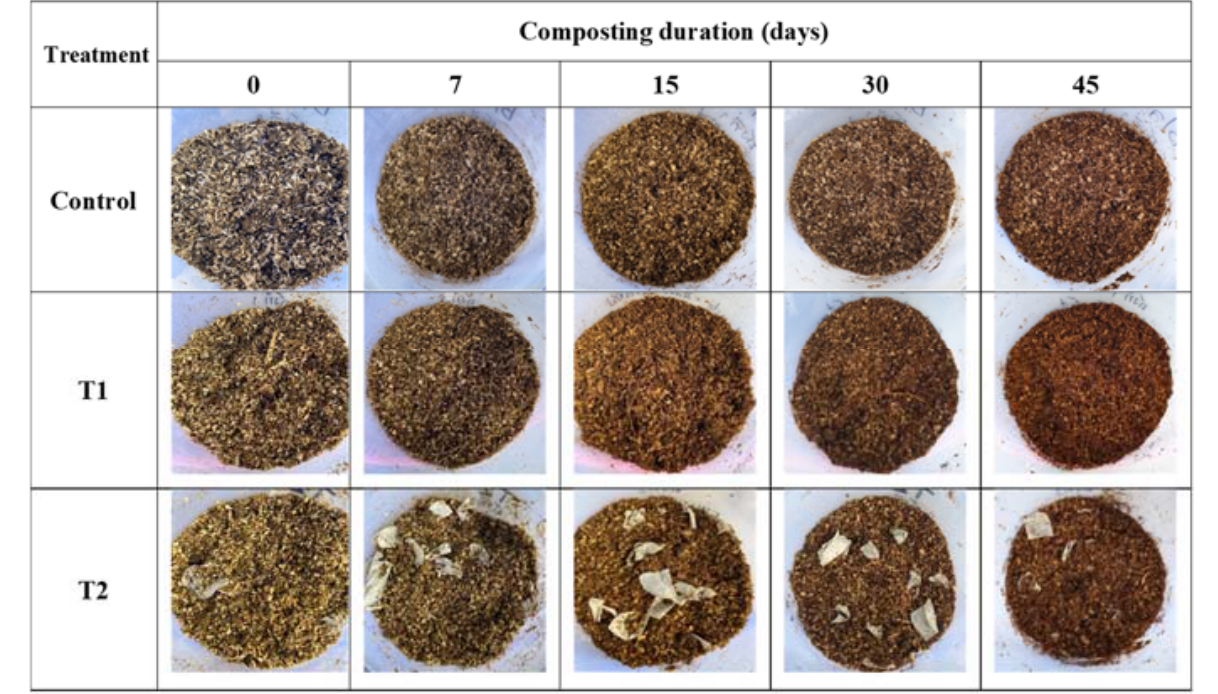
Figure 2. Physical appearance of soil amendment samples of control, T1, and T2 treatments at days 0, 7, 15, 30, and 45.